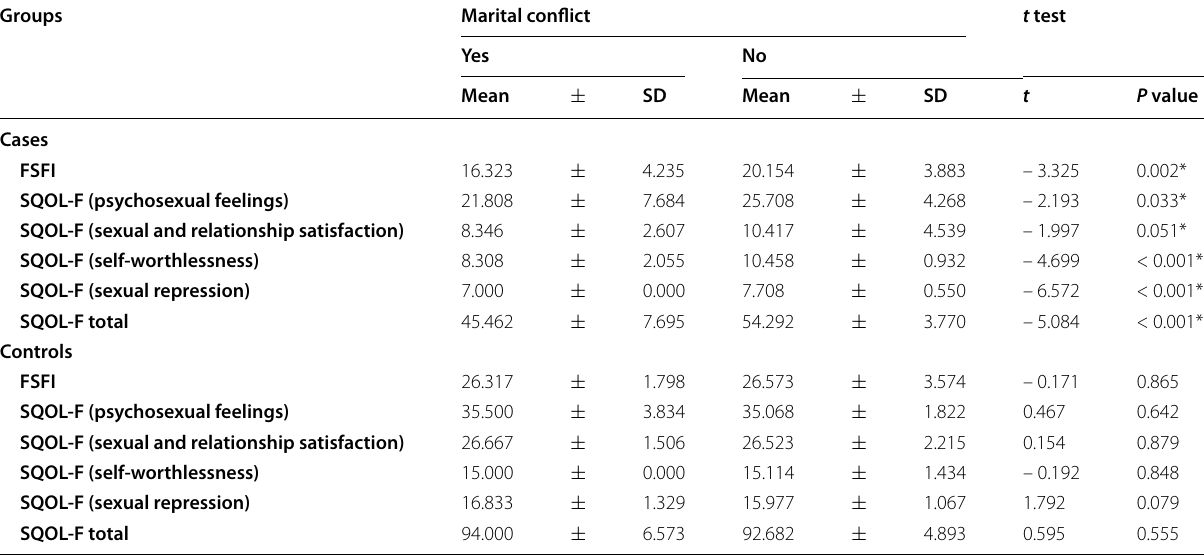
t test was used *Statistically significant ( P <